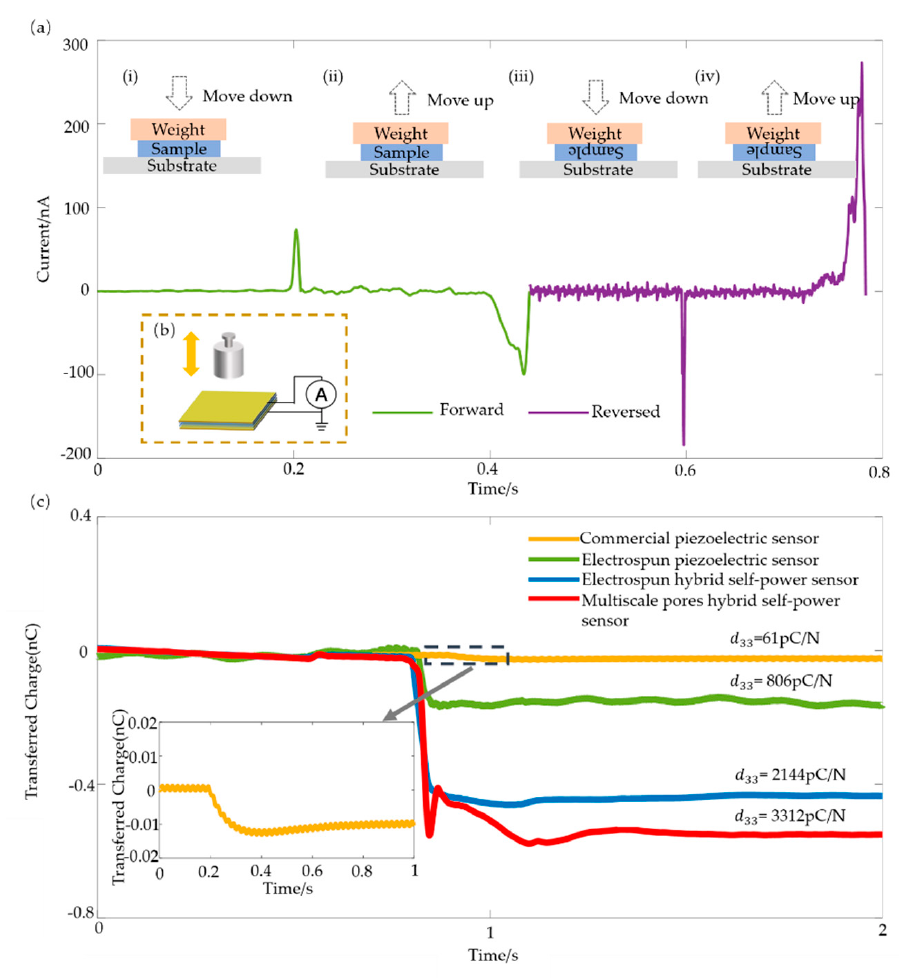
Figure 5. Schematic of the piezoelectrical effect and piezoelectric coefficient d 33 test. ( a ) Short-circuit current responses of the sensors during one cycle of pressing and releasing with the forward and reversed electrical connections. ( b ) Comparison of the transferred charge of the four sensors with different fabrication processes and microstructures during the test of d 33 . ( c ) The transferred charge and the corresponding piezoelectric coefficient for sensors with different structures under the same mechanical stimulation (inset is the enlarged view of the dashed frame).